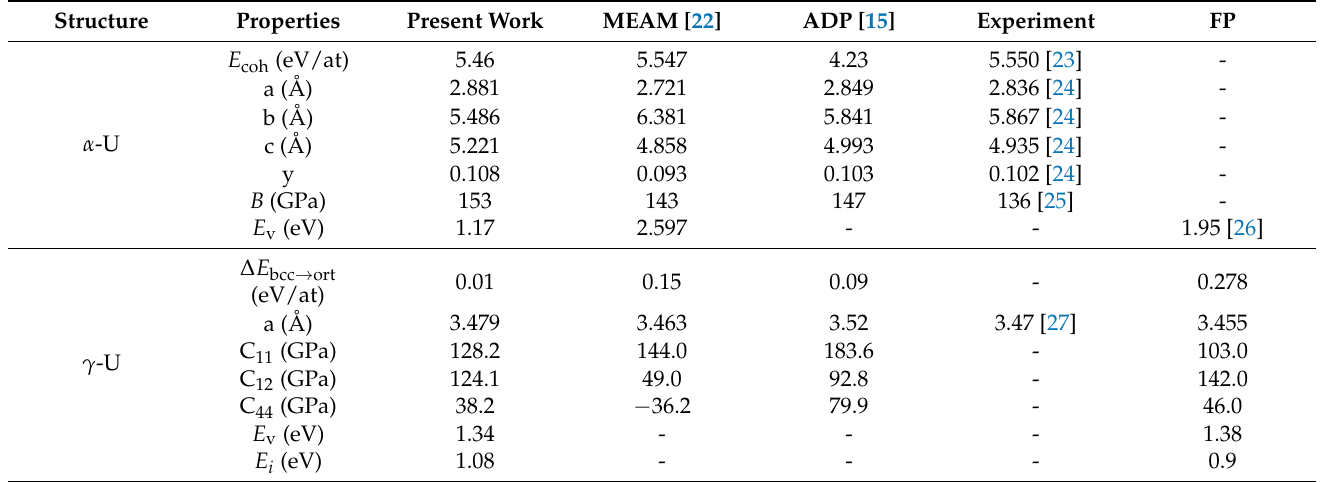
Table 2. Reproduced values of lattice constants, cohesive energies, and elastic constants of pure uranium. Structure